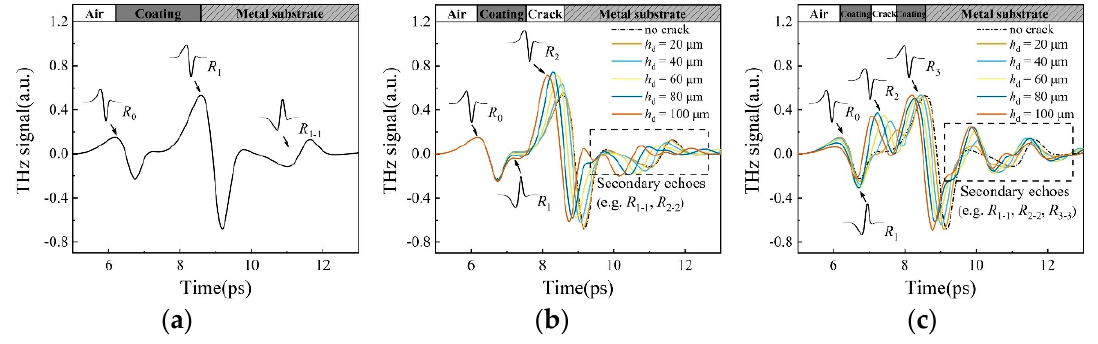
Figure 8. Simulation signal of terahertz wave propagation in coating ( h c = 225 μ m, h l = 100 μ m): ( a ) No cracks; ( b ) Interface cracks; ( c ) Internal cracks.